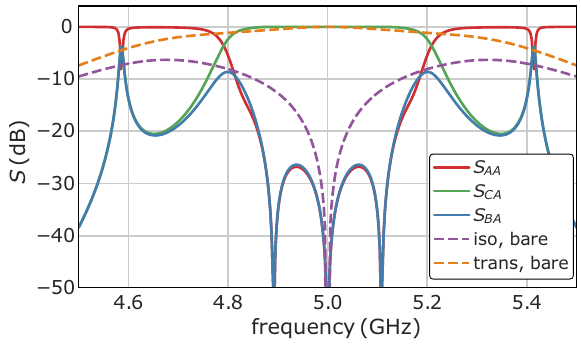
FIG. 17. Real and imaginary parts of the normalized port admittance (solid), along with their approximation (dashed) for the purpose of matching circuit design. Vertical dashed lines indicate detunings of ± γ 0 / 2.